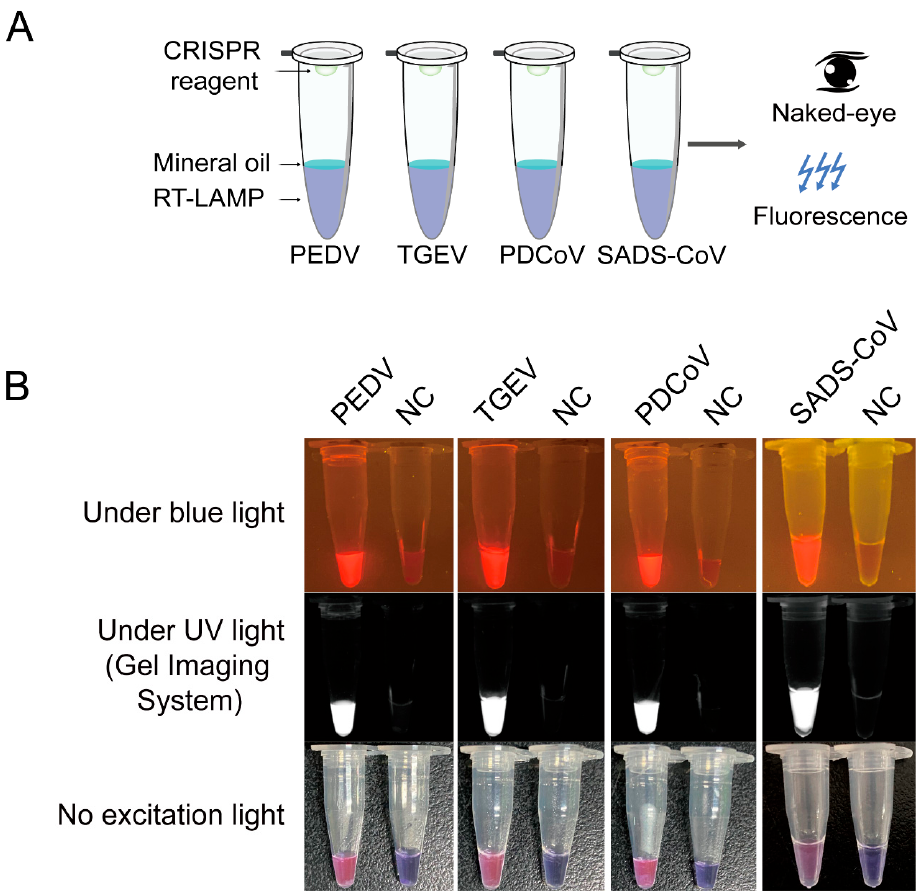
Figure 4. One-tube detection of four porcine coronaviruses in clinical samples based on CRISPR/Cas12a combined with RT-LAMP assay. ( A ) Diagram of principle of the contamination-free one-tube CRISPR/Cas12a combined with RT-LAMP assay detection of clinical samples. ( B ) Colorimetric/fluorescence readout of four porcine CoVs by one-tube multiplex RT-LAMP-Cas12a assay. CRISPR, clustered regularly interspaced short palindromic repeats; RT-LAMP, reverse transcription-loop-mediated isothermal amplification; No excitation light stands for white light; PEDV, porcine epidemic diarrhea virus; TGEV, transmissible gastroenteritis virus; PDCoV, porcine deltacoronavirus; SADS-CoV, swine acute diarrhea syndrome coronavirus; NC, negative control.